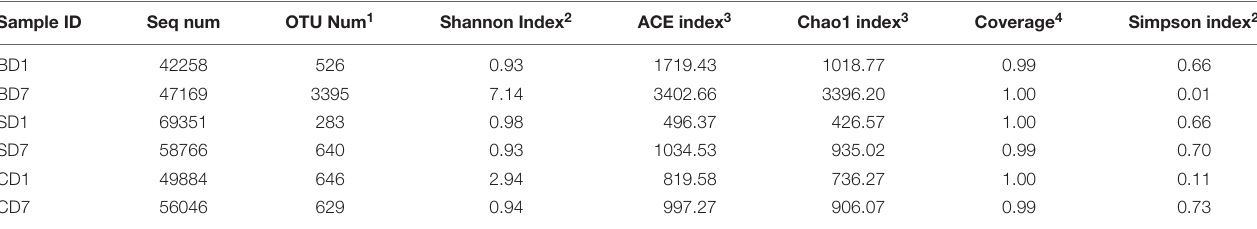
TABLE 5 | Diversity and richness indices relative to each